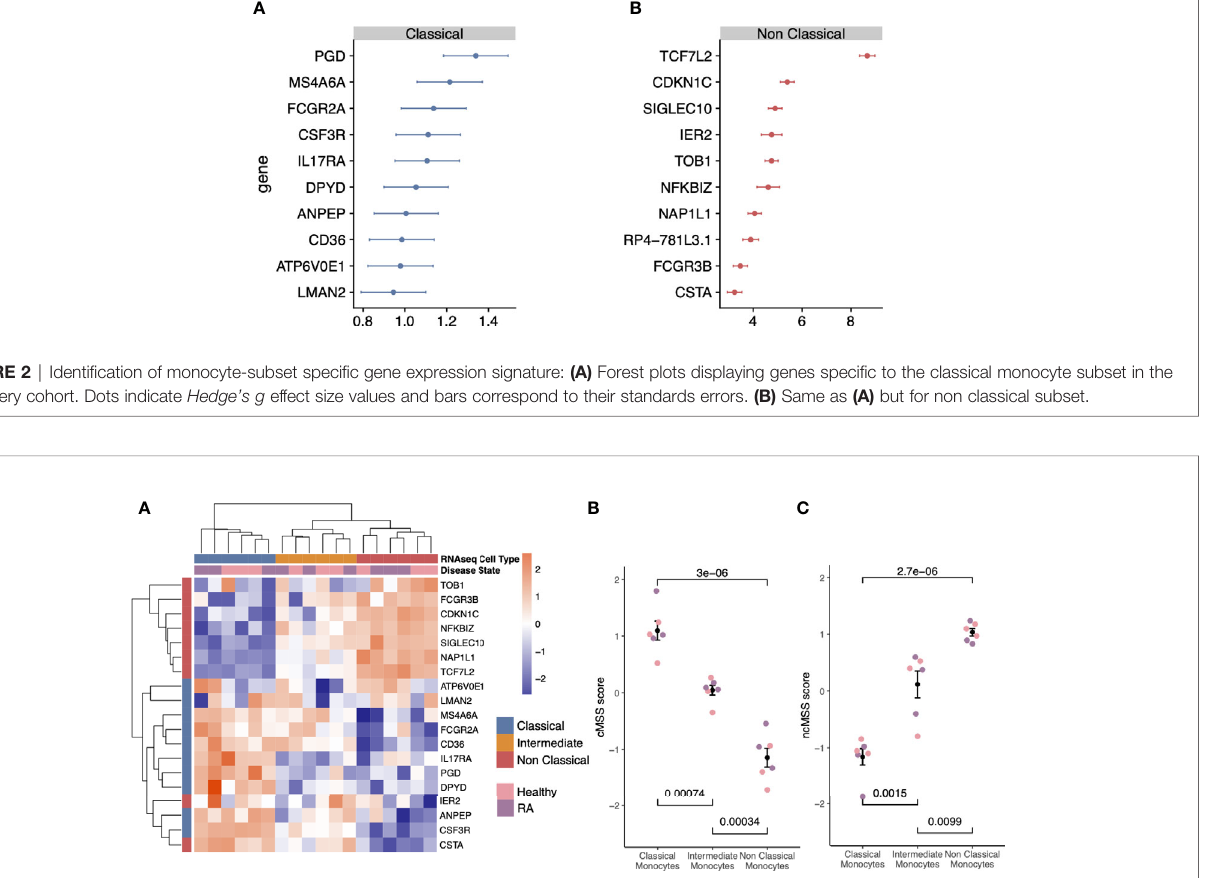
FIGURE 3 | Subset-speci fi c genes are independent of disease state: (A) Heat-map showing expression of subset signature genes (rows) on sorted human monocytes (columns) from independent RNA-seq validation. Samples are labeled by cell type and disease state. (B) Bee-swarm plots displaying classical monocyte signature (cMSS) scores across monocyte subsets and disease condition. Signi fi cance was computed by t-test. (C) Same as (B) for non-classical monocyte subset signature (ncMSS)